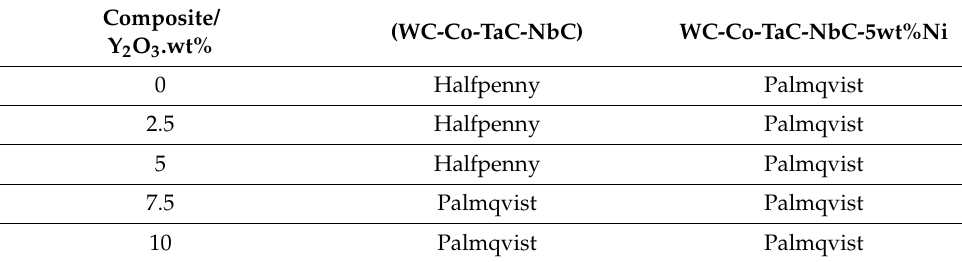
Table 3. Fracture toughness and crack type developed for the sintered alloys.